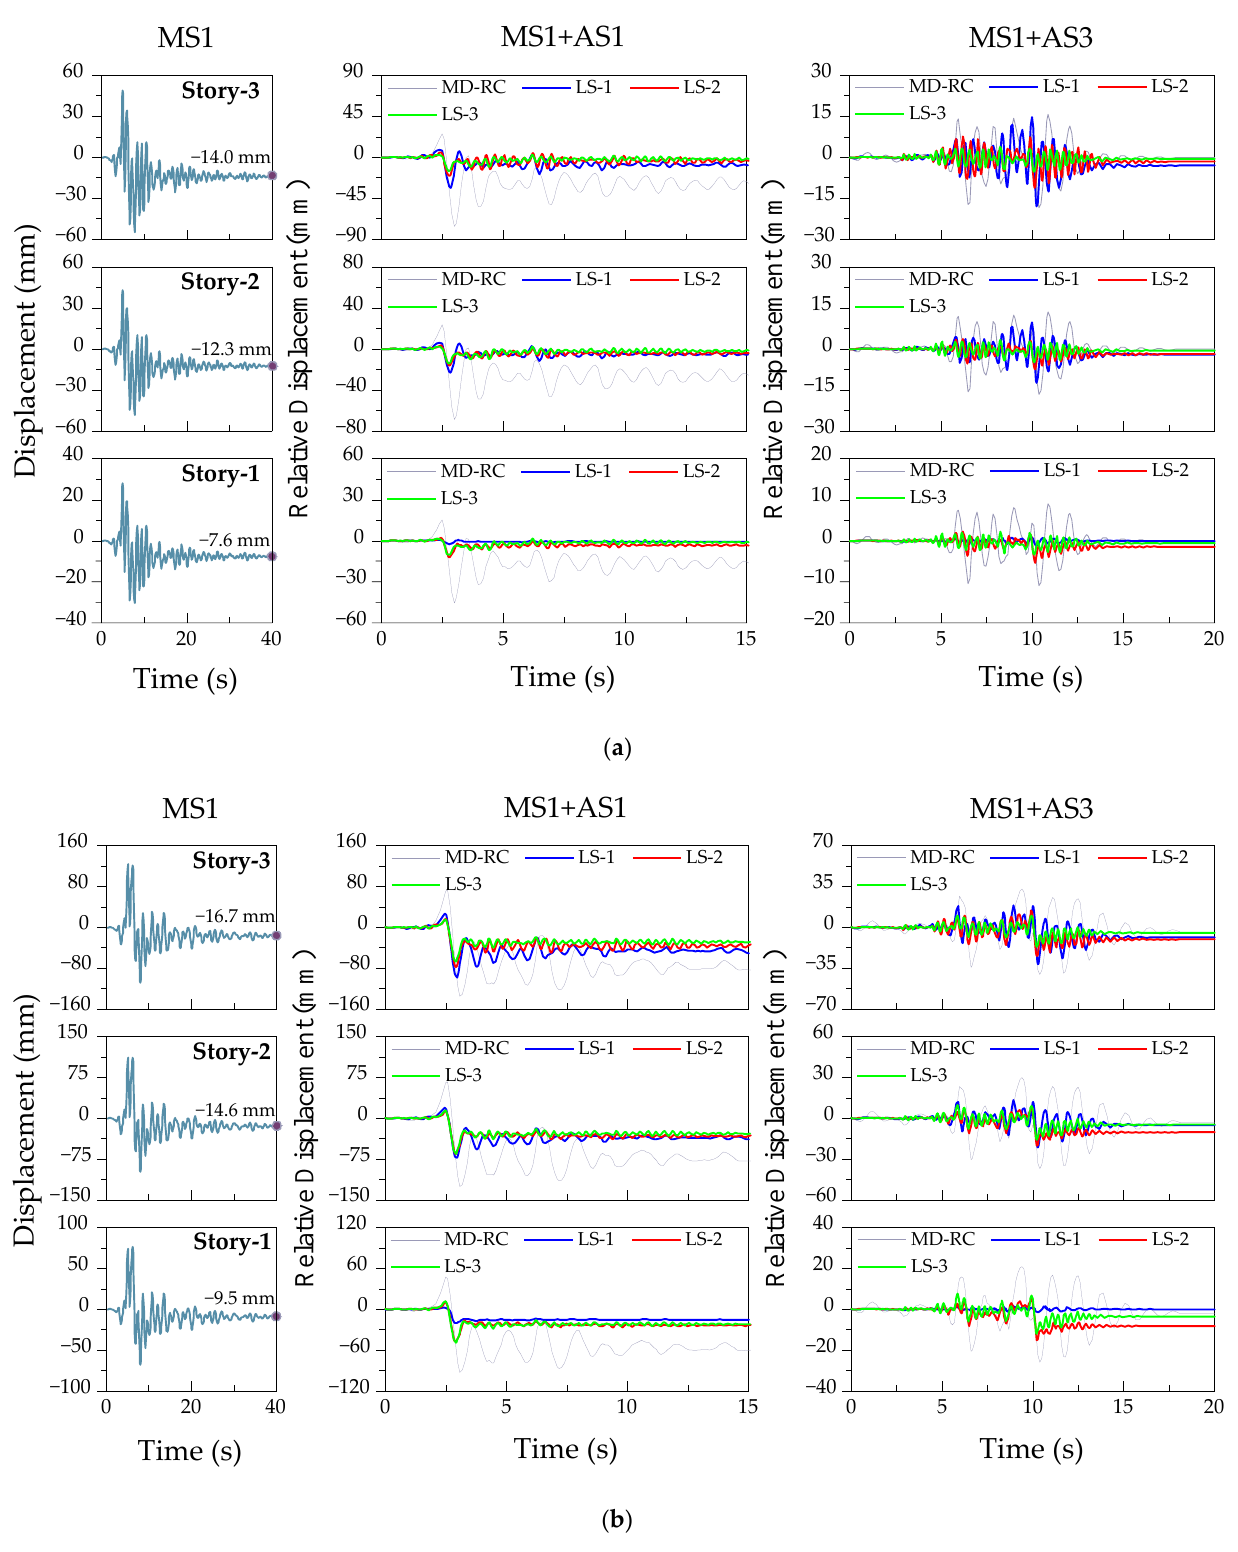
Figure 10. Displacement time histories of DS1 ( a ) and DS2 ( b ) damage states MD-RC frame due to MS1 mainshock before and after retrofitting subjected to AS1 and AS3 aftershocks.